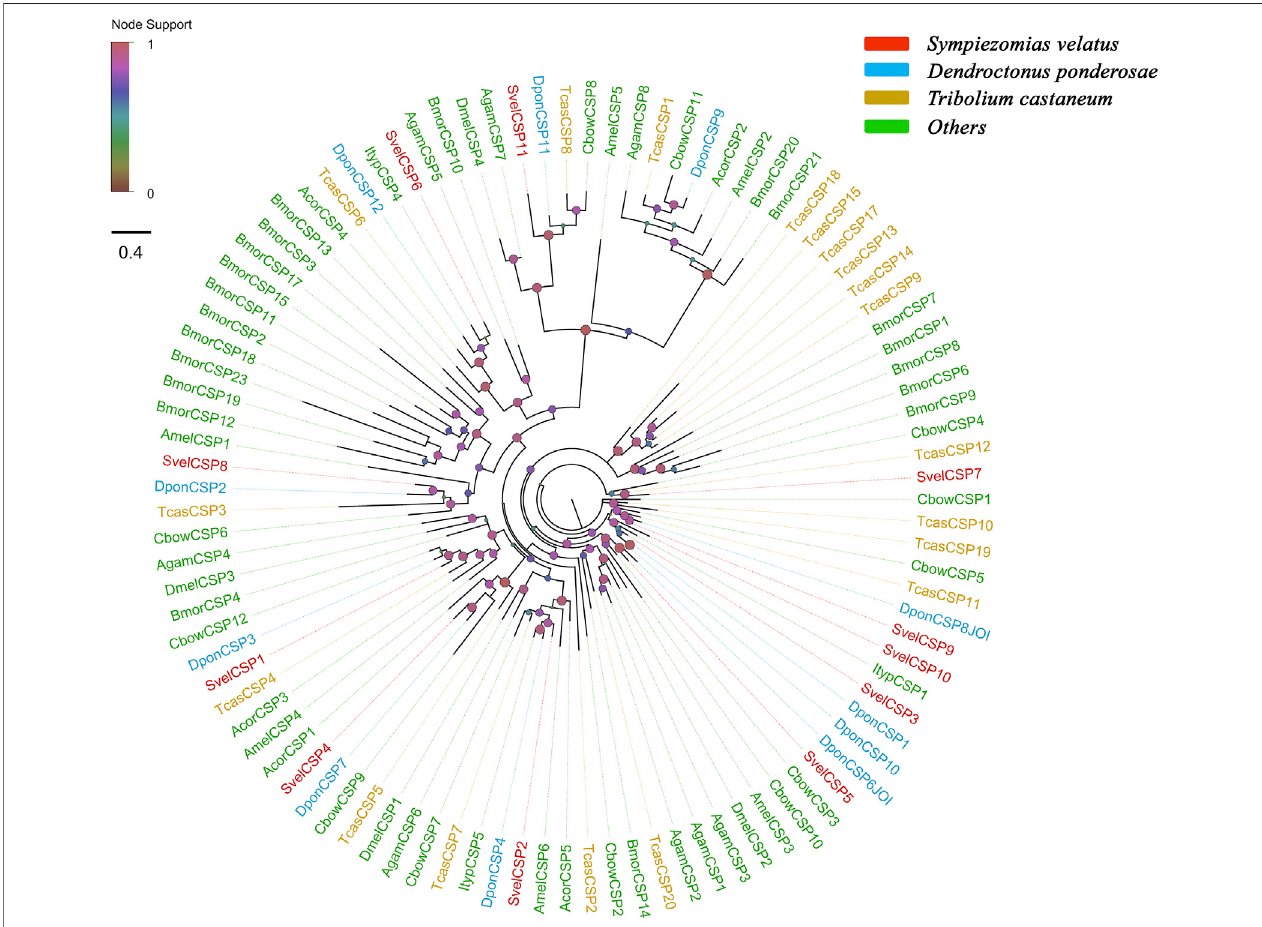
FIGURE 2 | Phylogenetic tree of candidate chemosensory proteins (CSPs). The CSP sequences included were from Sympiezomias velatus (Svel, red), Dendroctonus ponderosae (Dpon, blue), Tribolium castaneum (Tcas, yellow), and other species (green), including Drosophila melanogaster (Dmel), Anopheles gambiae (Agam), Bombyx mori (Bmor), Colaphellus bowringi (Cbow), Anomala corpulenta (Acor) and Ips typographus (Ityp). The unrooted tree was constructed using FastTree based on a MAFFT alignment. The local support values based on the Shimodaira-Hasegawa (SH) test are indicated by the colored circles and increase with the brightness and size of the